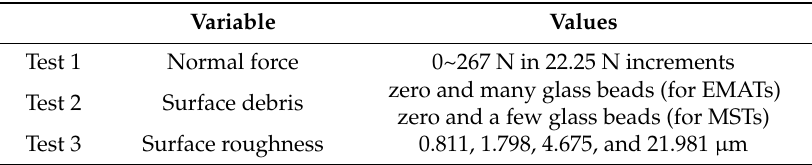
Table 4. Summary of experimental variables for each